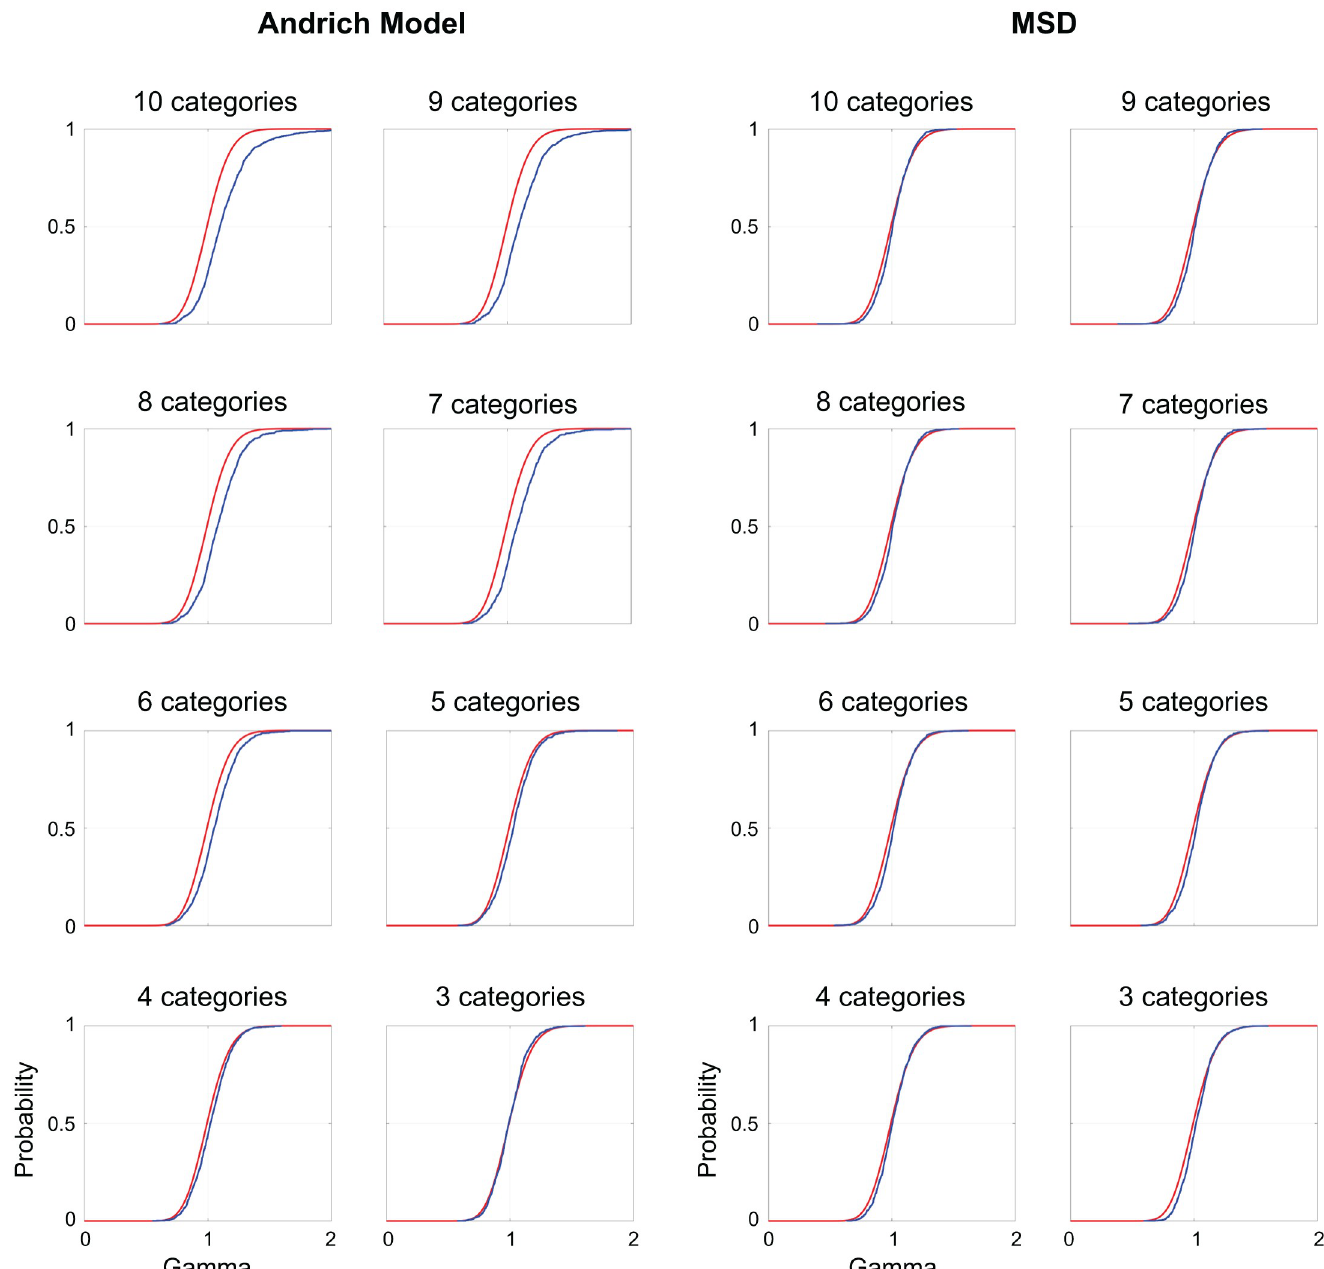
Fig 2. Comparing person infit mean squares for the Andrich model and MSD. Cumulative distribution functions of the person infit mean squares (blue curves) are compared to cumulative distribution functions of chi square divided by degrees of freedom (red curves), for the Andrich model (left) and MSD (right). The red and blue curves should be identical under the assumption that the only source of variance is random error. MSD satisfies this assumption better than the Andrich model as the number of rating categories